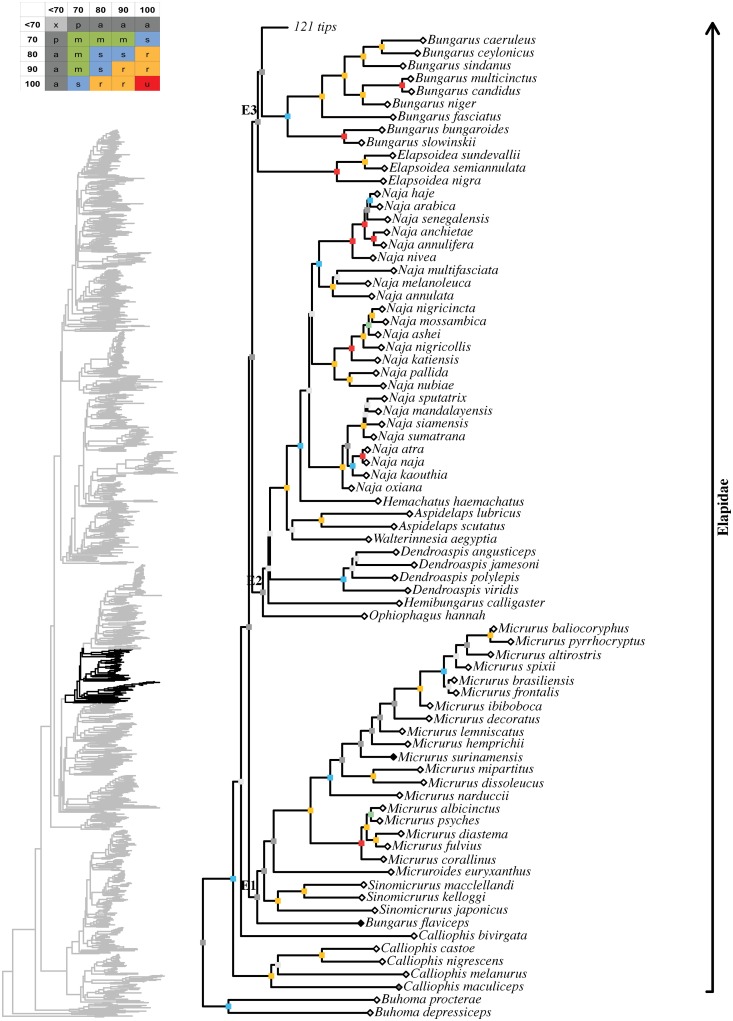
Maximum likelihood species-level phylogeny of Colubroides
(continued).Family Elapidae.